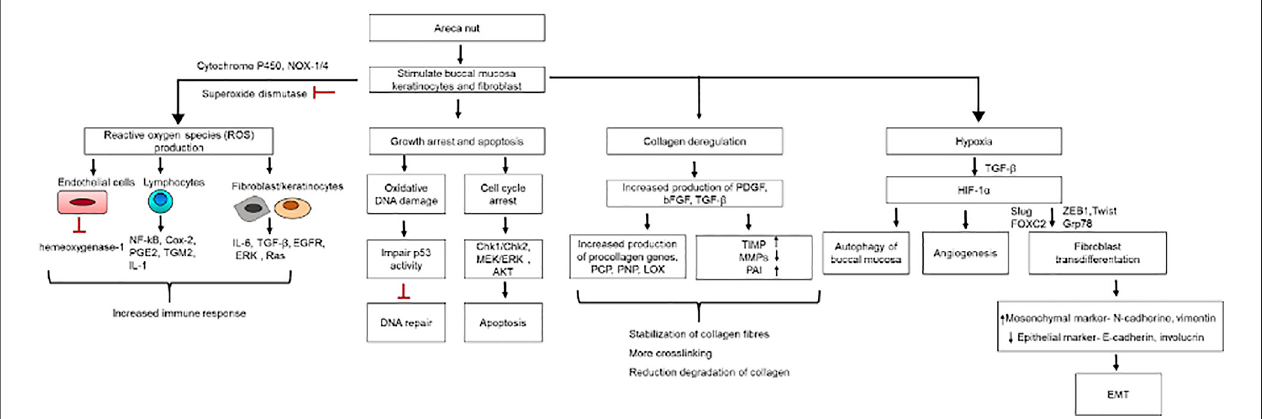
FIGURE 7 | OSMF pathogenesis: Cellular and molecular changes in buccal mucosa due to areca nut exposure.